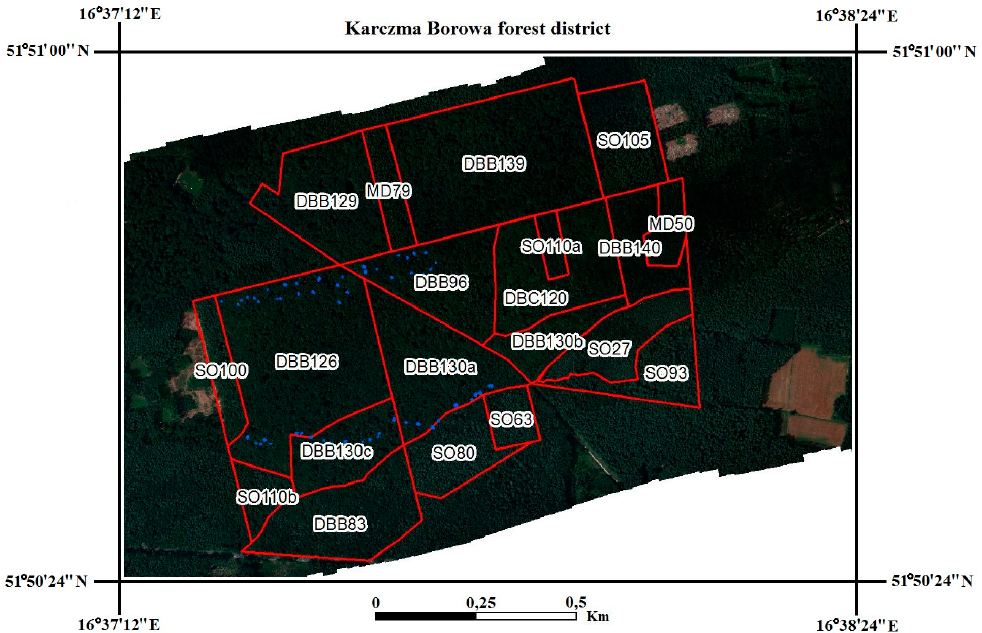
Figure 1. Map of the research plot in the Karczma Borowa Forest District in the adopted World Geodetic System 84 (WGS 84) reference system. The red color denotes the region of interest (ROIs) adopted in accordance with the divisions of the Forest Data Bank (FDB). The blue color denotes the positions of sample tress set out by the Forest Research Institute ( Q. robur ). Dominant species name with its age: DBB for Q. robur , DBC for Q. rubra , MD for Larix sp., SO for P. sylvestris .